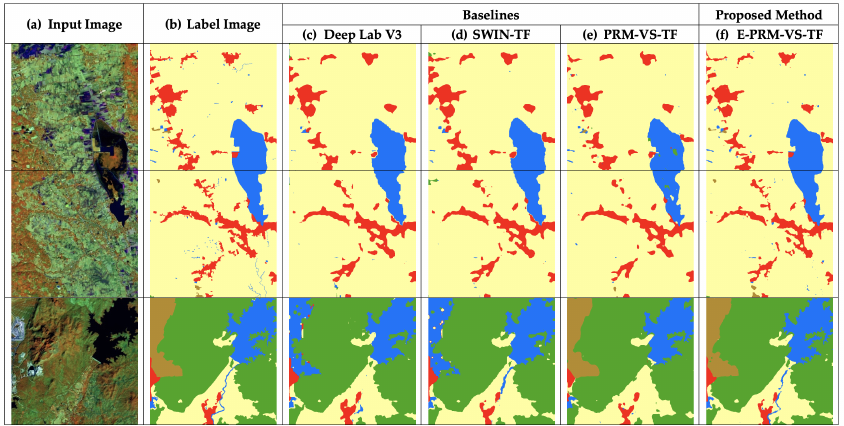
Figure 8. In the first two rows, the proposed method demonstrates sufficient performance for the urban predictions (red). In the third row, the miscellaneous results (brown) predicted by the proposed model (column f ) outperform all